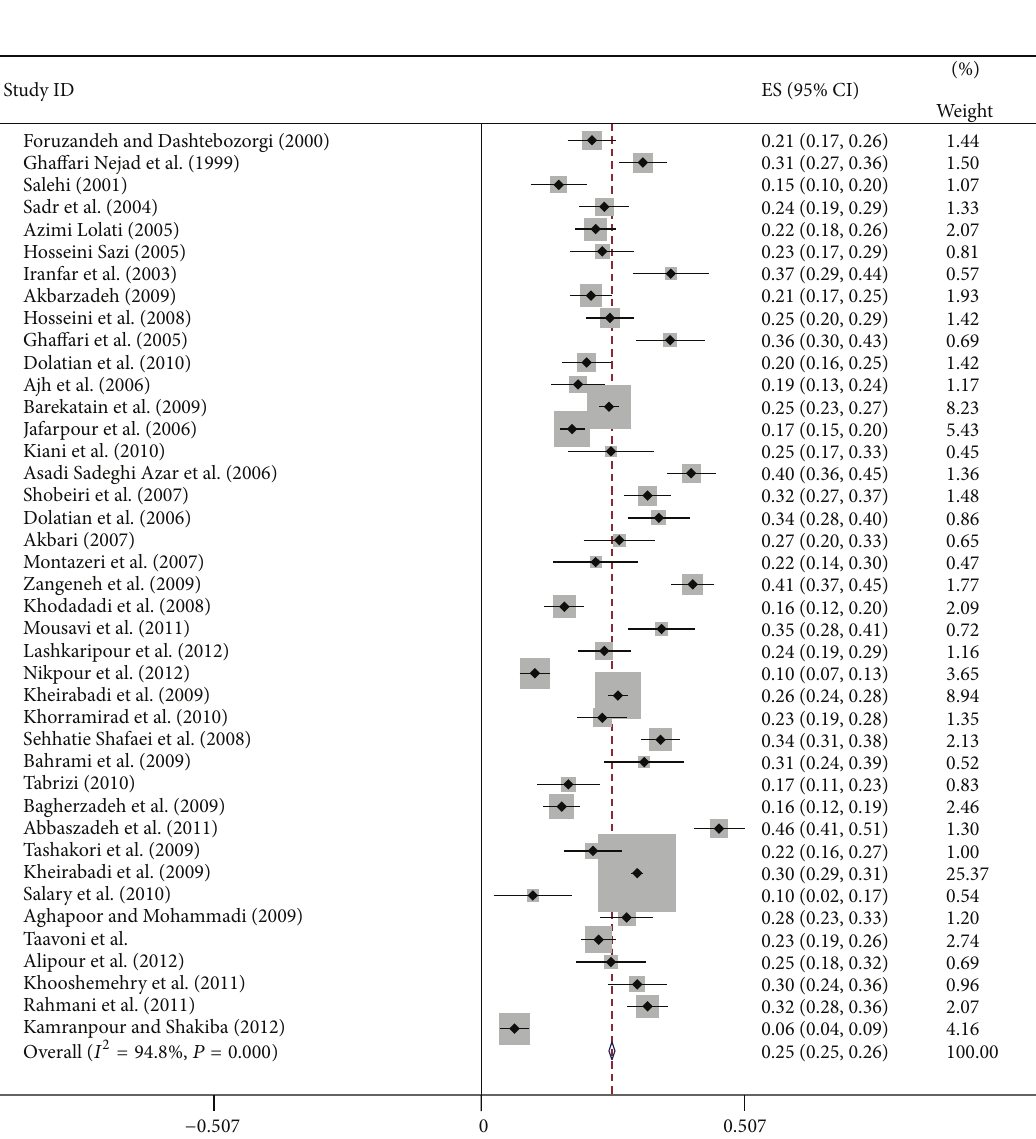
Figure 2: Forest plots for random effects meta-analyses. CI indicates confidence